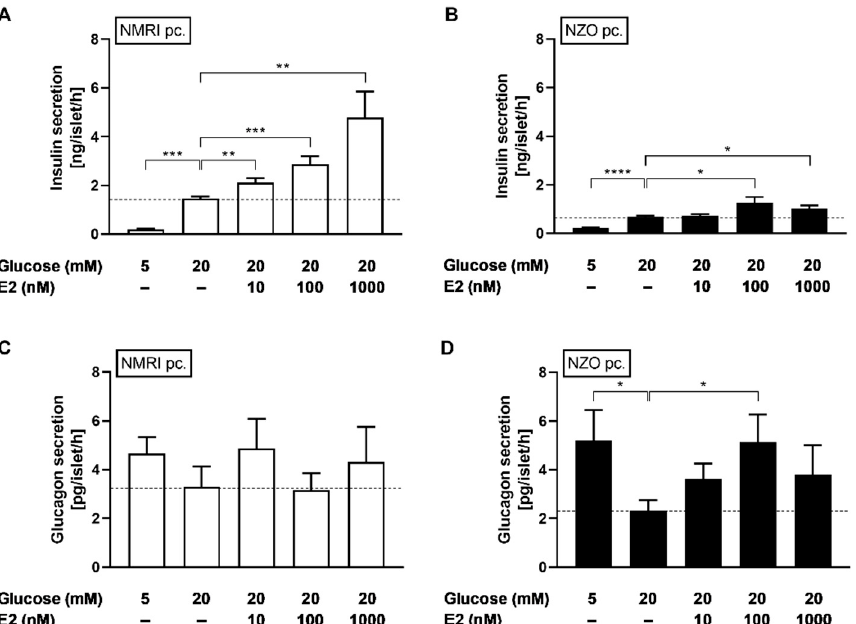
Figure 2. E2 improved insulin secretion but not glucagon secretion in freshly isolated islets. Insulin secretion (upper graphs) and glucagon secretion (lower graphs) of ( A , C ) preconceptional NMRI and ( B , D ) NZO islets after static incubation with 5 or 20 mM glucose in combination with E2. Data are presented as means ± SEM (( A ) n = 7–9, ( B ) n = 8–10, ( C ) n = 8–9 and ( D ) n = 9–10 animals per group). * p < 0.05; ** p < 0.01; *** p < 0.001, **** p < 0.0001.